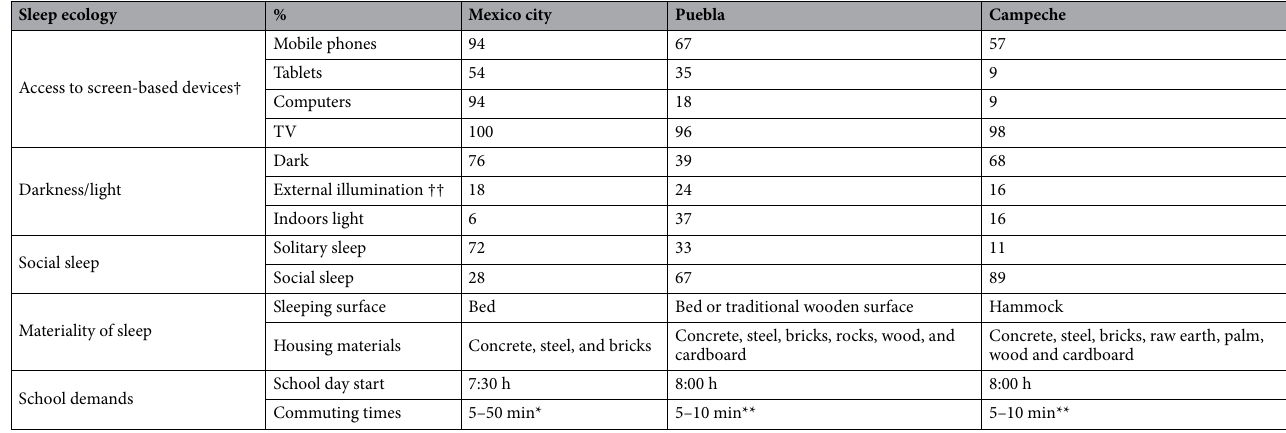
Table 1. Micro- and Macro-ecological characteristics of participants’ sleep by sites. Data are represented as percentages relative to each sample group. † Unlike urban participants, most Totonac and Maya adolescents from Puebla and Campeche do not personally own screen-based devices but borrow them from a family member. Consequently, their access to such devices is more restricted than participants from Mexico